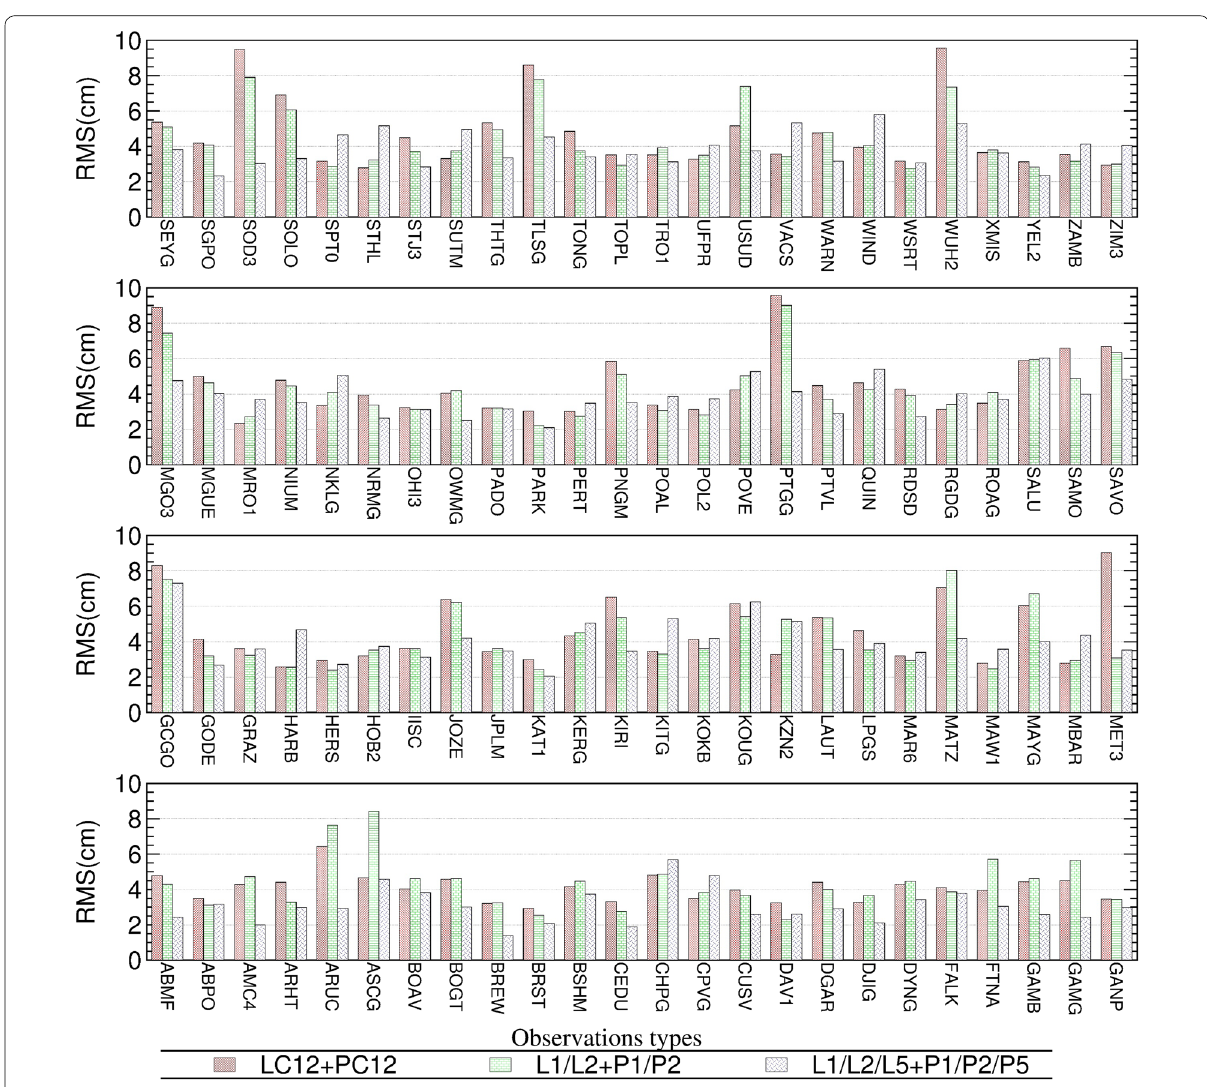
Fig. 5 3-D RMS of the GPS PPP results after convergence for the 96 stations during GPS week 2057